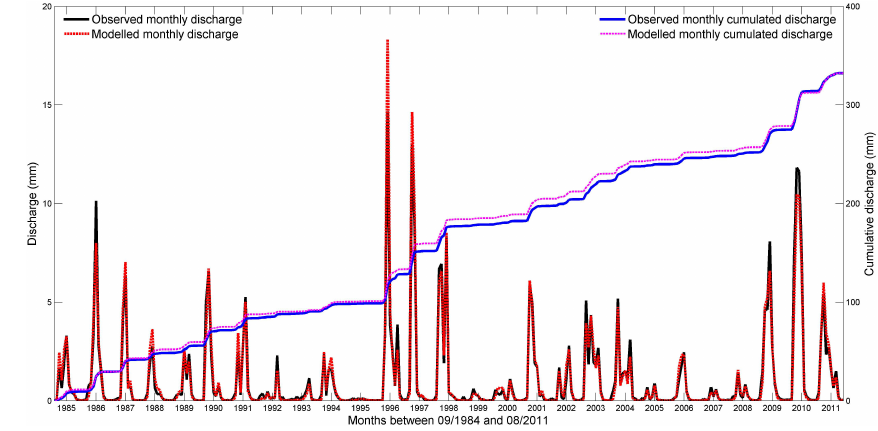
Fig. 9. Simulated discharge over the period 1984–2011 with observed precipitation and potential